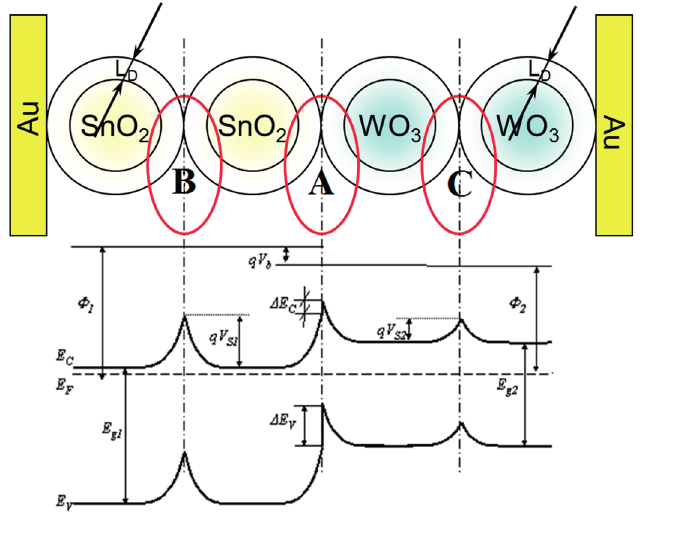
Figure 14. Schematic diagram of the contacts between the grains of tin dioxide and tungsten oxide as well as the band structure of the contacts formed in the ambient